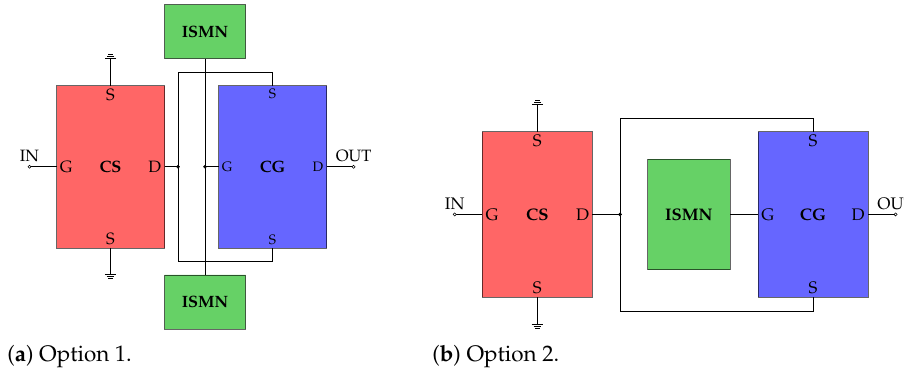
Figure 12. Possible symmetrical cell